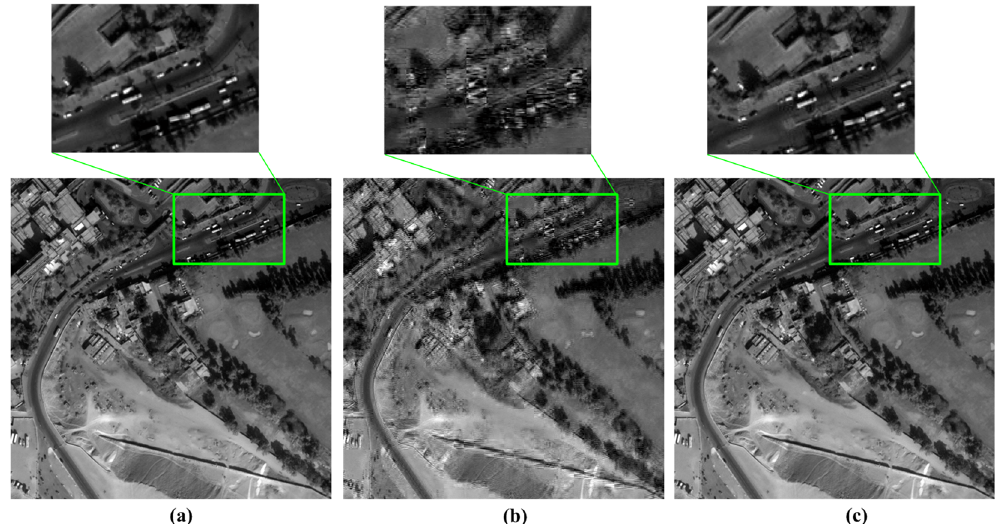
Figure 3. Reconstructed images obtained via PCT-CS and our method with M = 190 when the block size is 16 × 16 pixels: the original image ( a ); the reconstructed image obtained via PCT-CS, which exhibits blocking effects ( b ); and the reconstructed image obtained using our method, which does not exhibit blocking effects ( c ).